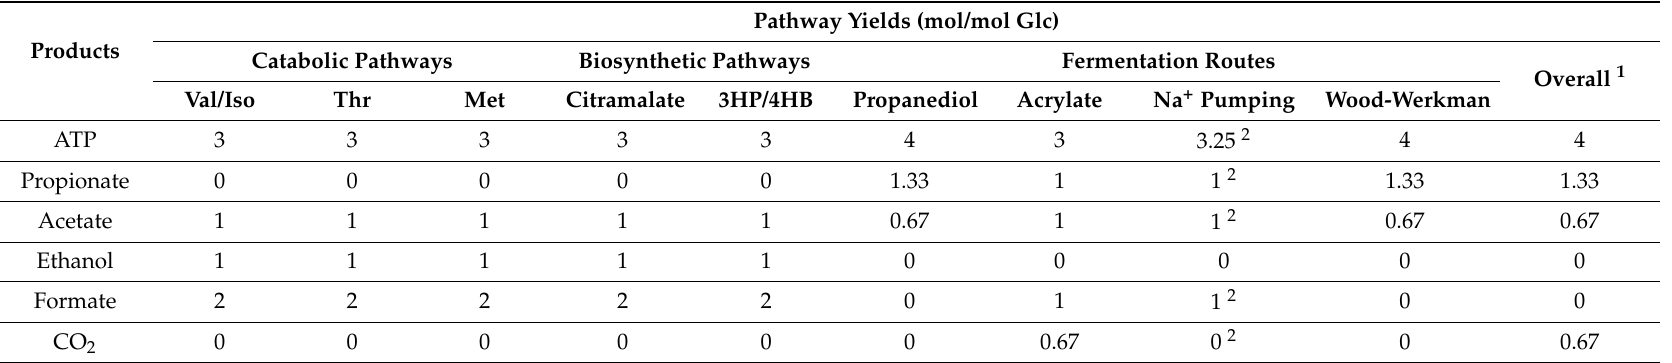
Table 6. Maximum energy yield analysis of all metabolic pathways leading to propionate